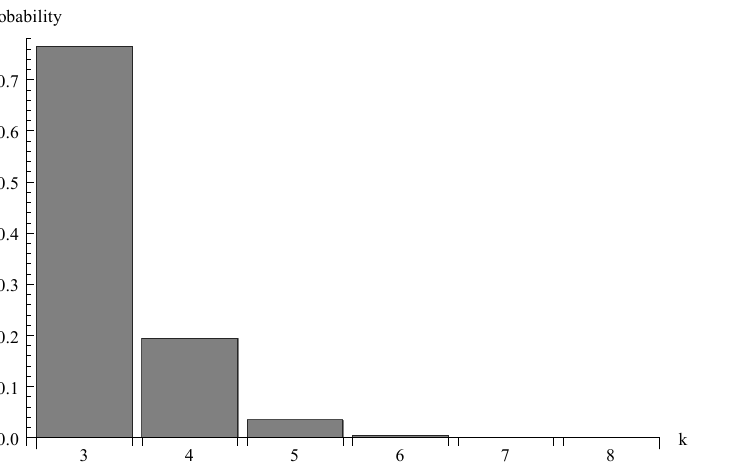
Figure 7. Number of packets of at the completion epoch of idle period for λ = 1.1.